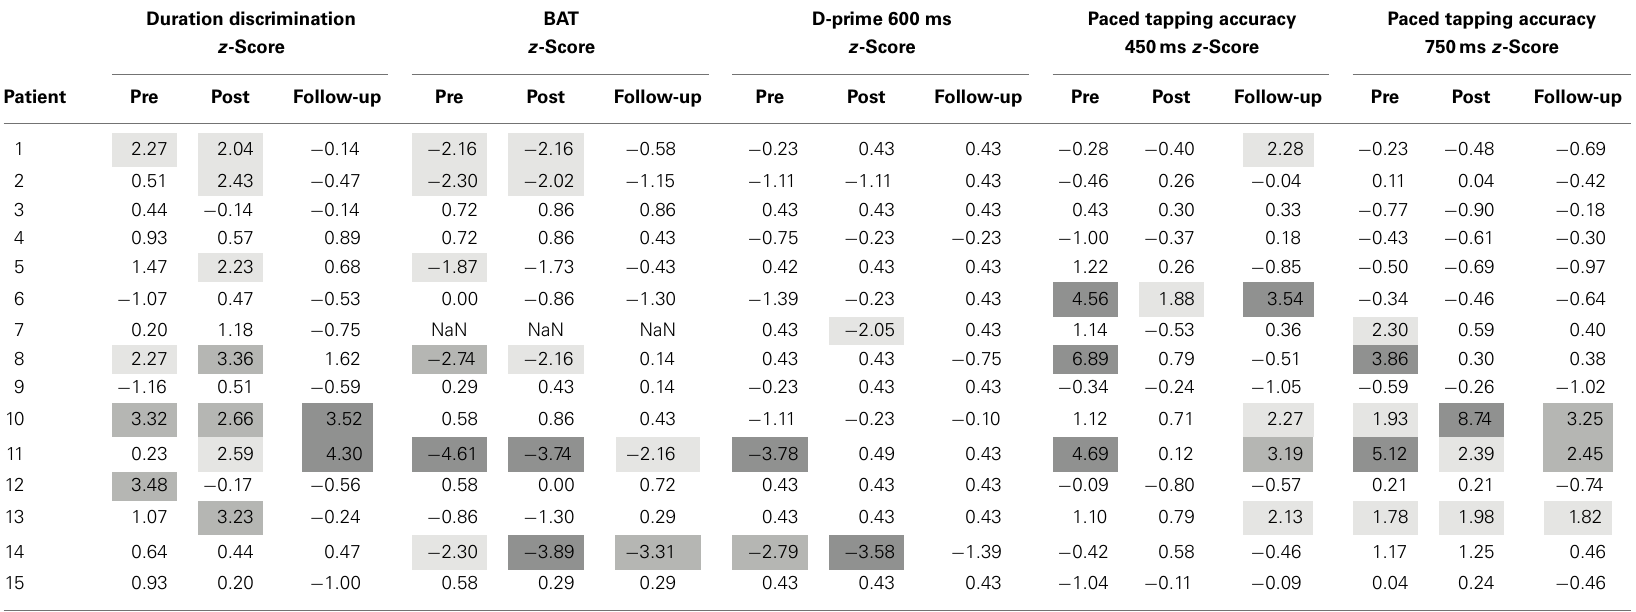
Values highlighted in gray indicate significant differences between the performances of patients and of healthy controls, as assessed with corrected t-tests (Crawford and Garthwaite, 2002). ‘NaN’ indicates missing